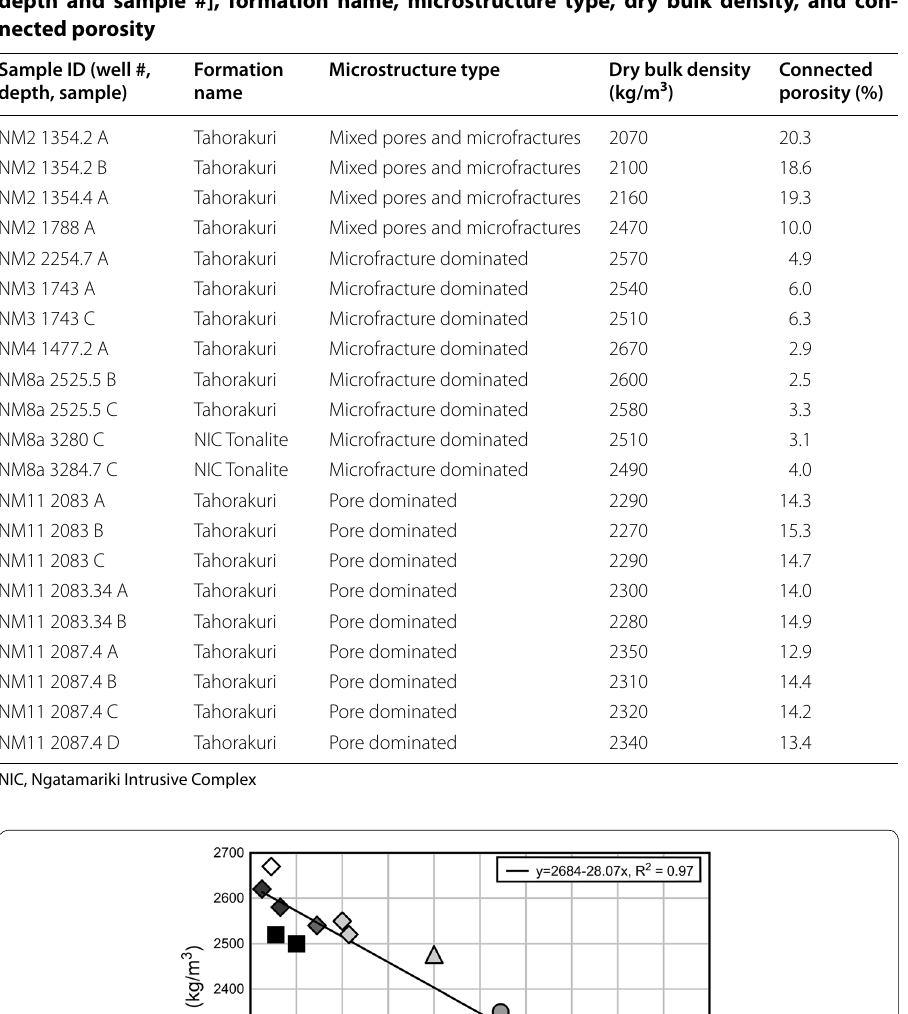
Table 4 Sample cores and their associated sample ID [consisting of well number (NM#), depth and sample #], formation name, microstructure type, dry bulk density, and